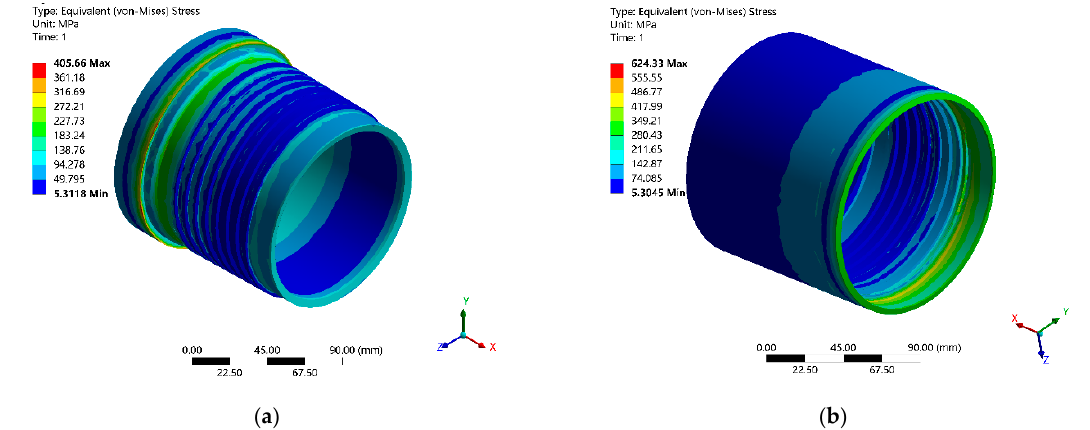
Figure 13. Thread stress nephograms with a pretightening angle of five degrees: ( a ) pin joint and ( b ) box joint.